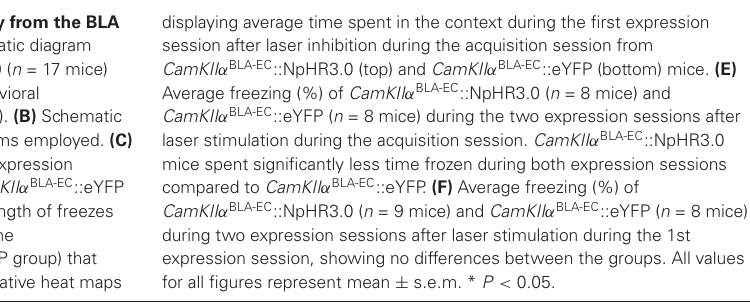
FIGURE 2 | Photoinhibition of the glutamatergic pathway from the BLA to the EC during contextual fear conditioning. (A) Schematic diagram showing optical fiber placement for CamKII α BLA-EC ::NpHR3.0 ( n = 17 mice) and CamKII α BLA-EC ::eYFP ( n = 16 mice) in the EC for all behavioral experiments (D = dorsal; V = ventral; M = medial; L = lateral). (B) Schematic illustrating the different contextual dear conditioning paradigms employed. (C) Histogram depicting the number of freezes during the first expression session in the CamKII α BLA-EC ::NpHR3.0 group (left) and CamKII α BLA-EC ::eYFP (right) after laser inhibition during the acquisition session. Length of freezes were cut off at 30 s, although there were a few bouts (1 in the CamKII α BLA-EC ::NpHR3.0 group; 3 in the CamKII α BLA-EC ::eYFP group) that lasted longer than our 30 s cutoff time epoch. (D) Representative heat maps